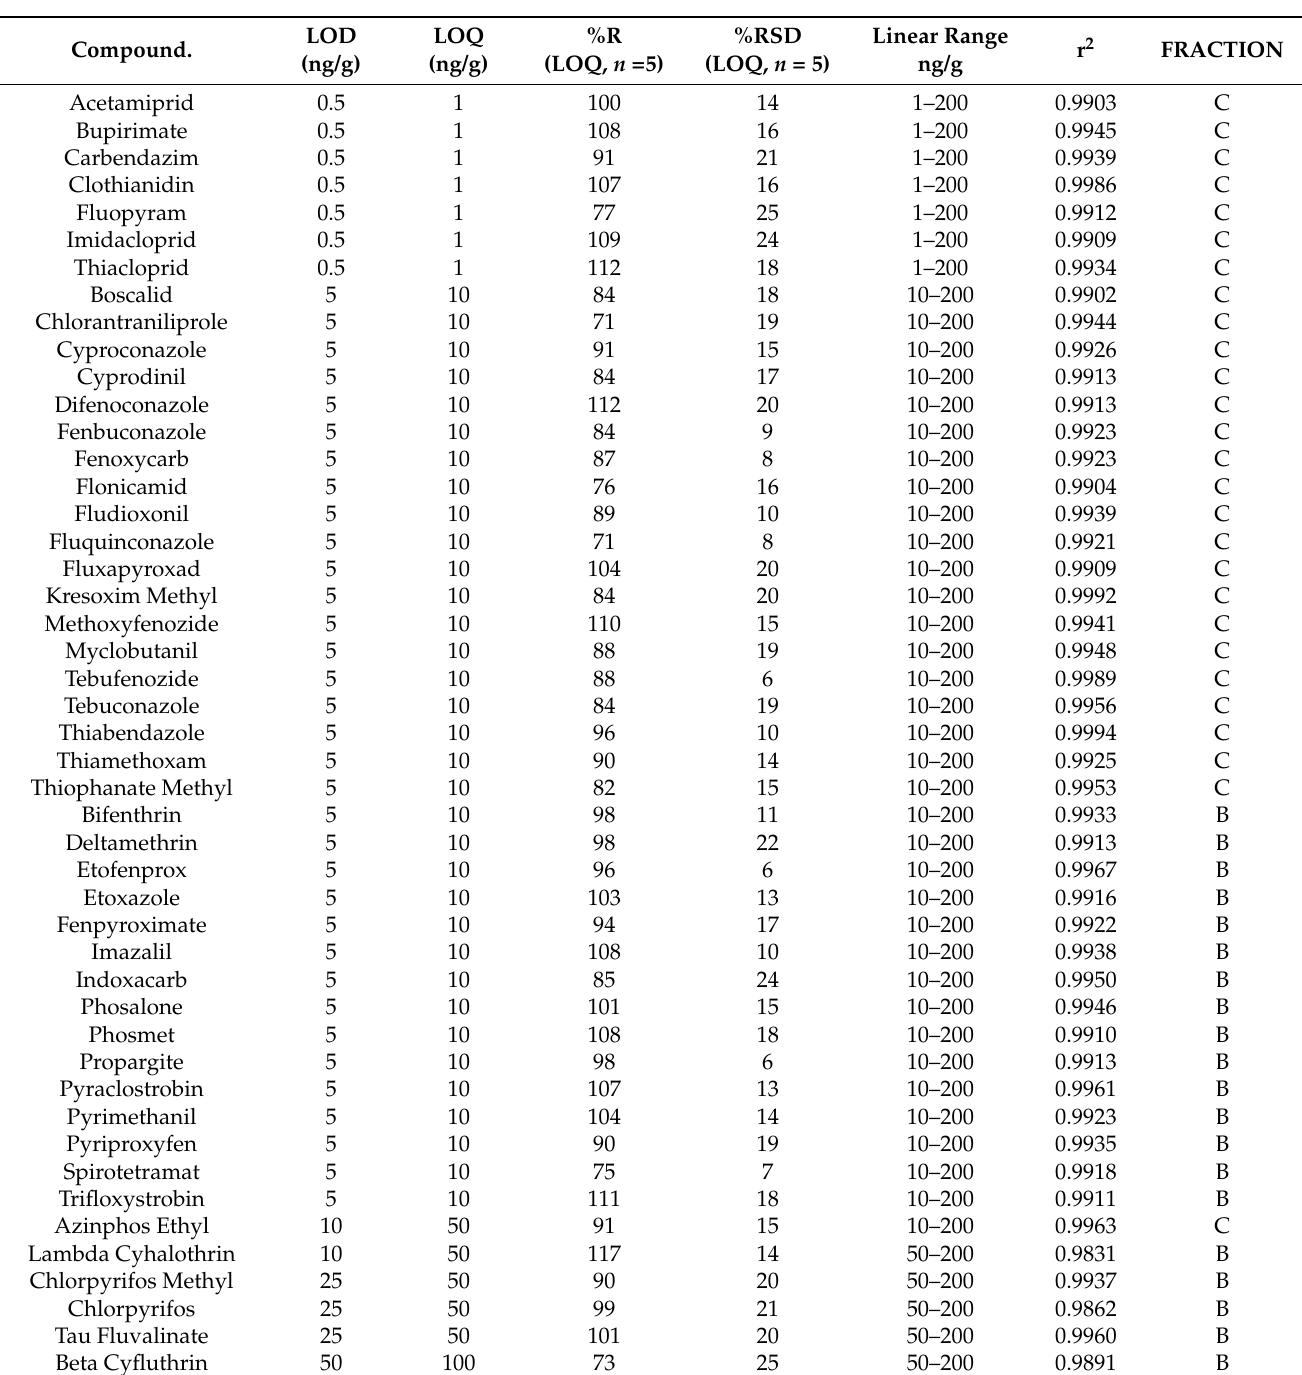
Table 2. Method performance parameters in